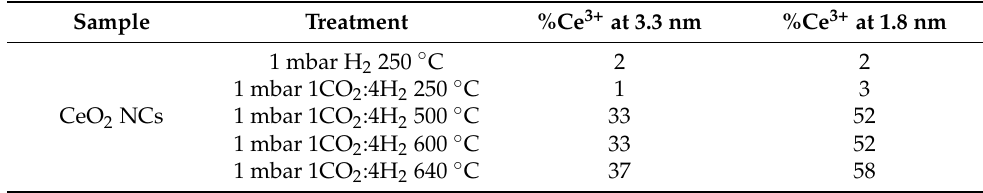
Table 2. Ce 3+ percentages for the as-prepared samples estimated from Near Ambient Pressure X-ray Photoelectron Spectroscopy (NAP-XPS) experiments under different